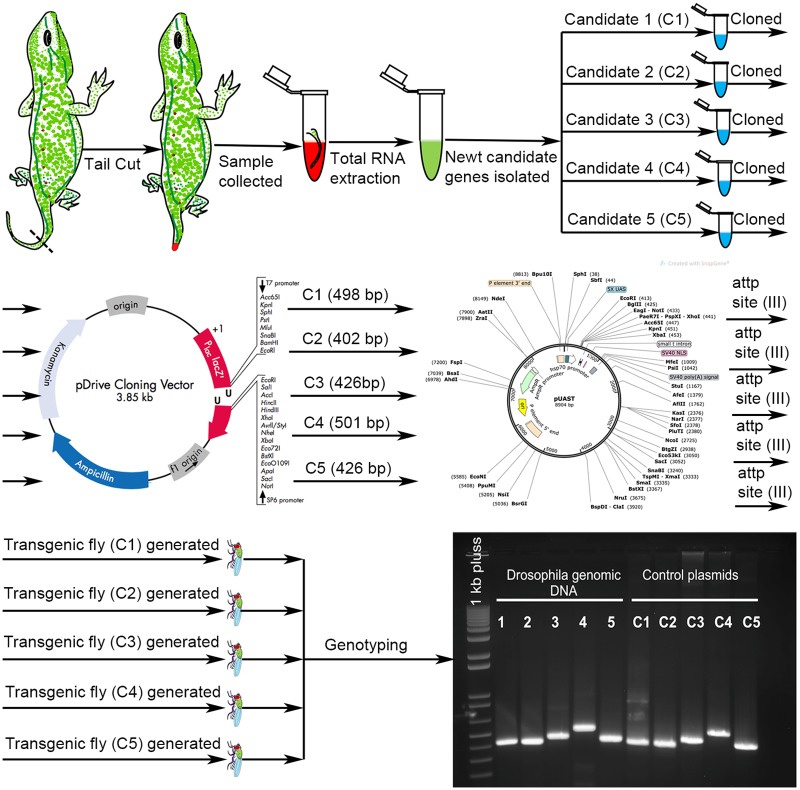
Schematic representation of generation of transgenic Drosophila.Novel Newt candidate genes were used to create 5 transgenic flies. Each fly had a single copy of newt candidate gene (C1, C2, C3, C4 or C5) inserted at chromosome III. After generating transgenic flies, genotyping was performed to check if Newt genes have been properly incorporated in Drosophila genome.